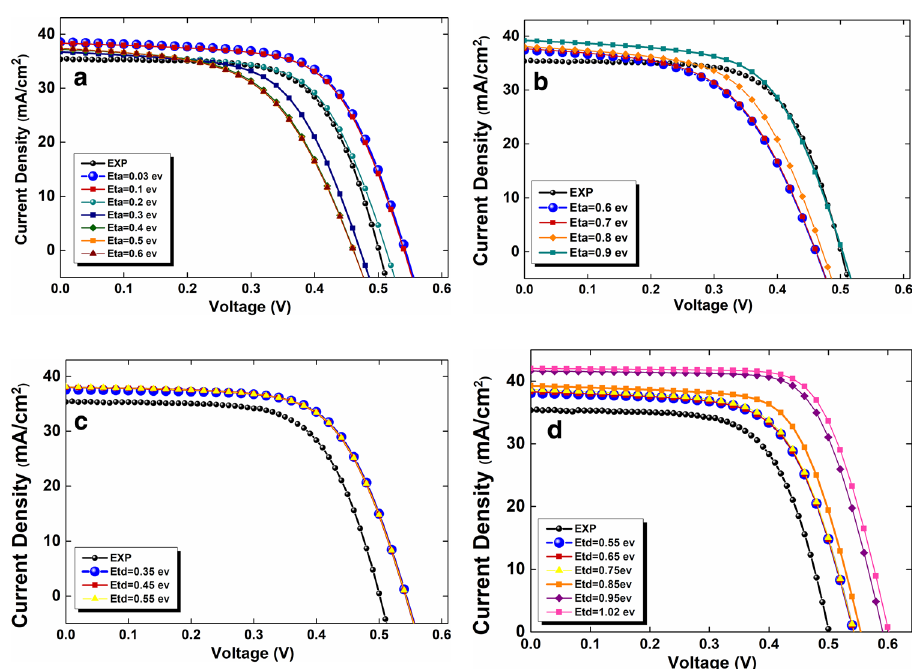
Figure 6. The effect of the absorber bulk defects positions on the current density versus voltage in range of ( a ) 0.03 eV to 0.6 eV (acceptor defect), ( b ) 0.6 eV to 0.9 eV (acceptor defect), ( c ) 0.35 eV to 0.55 eV (donor defect), and ( d ) 0.55 eV to 1.02 eV (donor defect) (the choice of ranges was based on Density Functional Theory (DFT) calculations 36